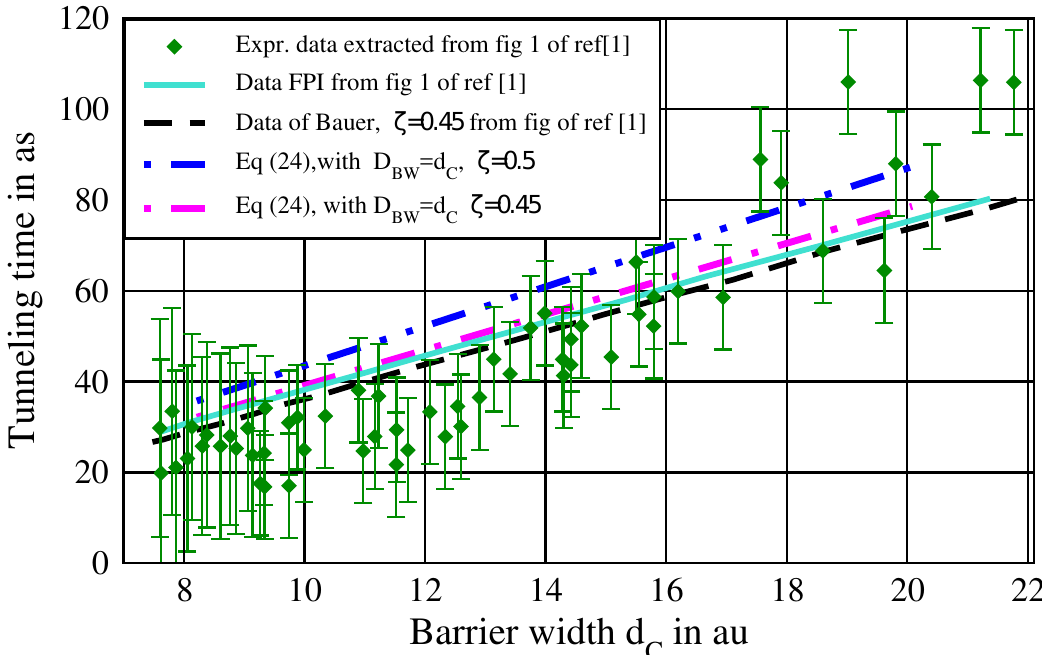
Figure 3. (Color online) Graphic display. The horizontal axis (classical) is barrier width d C in au and the vertical axis the tunneling time in as. The figure reproduces Figure 1 of [1] (using a figure digitizer), the tunneling time of the Bauer formula for ξ = 0.45, the Feynman path integral (FPI) and the experimental data; note that these data are extracted from Figure 1 of [1]); compare Figure 3d of [6]. Together with the formula in Equation (24) Υ B ( d C ) (same formula of [1]), for ξ = 0.45, ξ = 0.5, we reproduced the result of